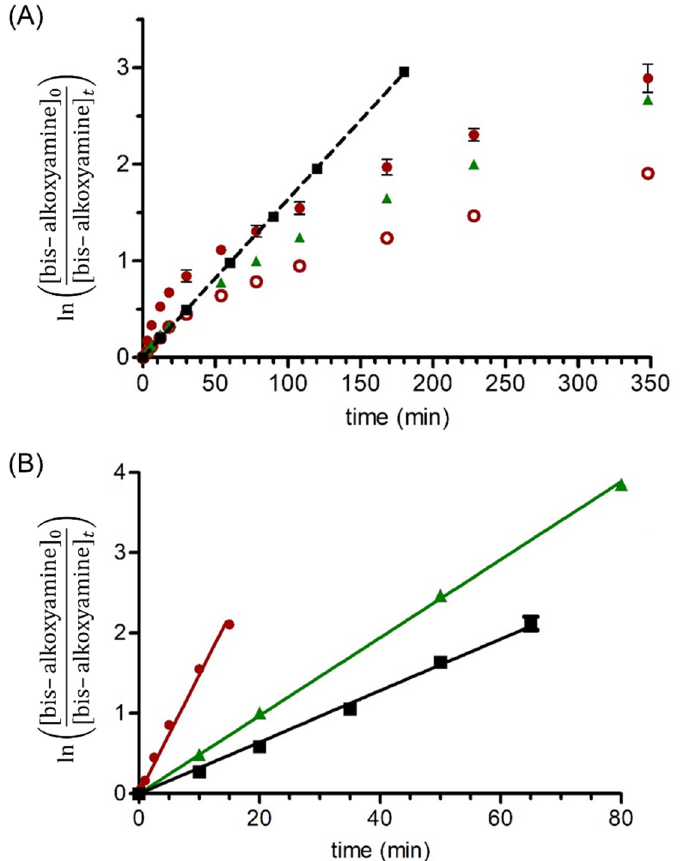
Figure 3. Kinetics for room temperature green-LED (2 × 9 W bulbs) induced decomposition in DCE at ( A ) [bis-alkoxyamine] = 5 mM and ( B ) [bis-alkoxyamine] = 0.25 mM, where CF 3 -Bis-TEMPO-Vis (green triangles, green line), Bis-TEMPO-Vis (red filled circles, red line), Bis-TEMPO-Vis with added free TEMPO (1.3 equiv., red open circles), and CF 3 -quinone epoxide 1 (black squares and black line).